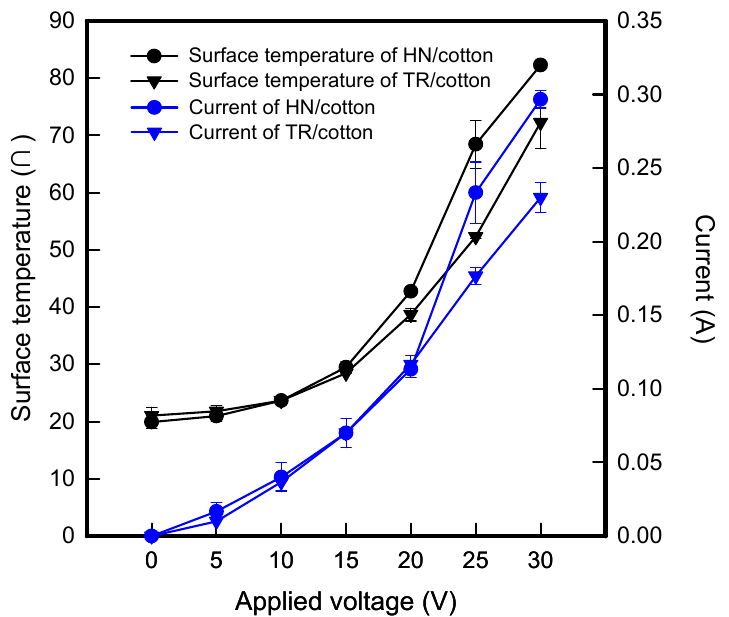
Figure 3. Surface temperature and Current-voltage (I-V) curve CFDM 3D printed graphene/PLA auxetic patterns/cotton composite fabric with honeycomb and truss pattern.